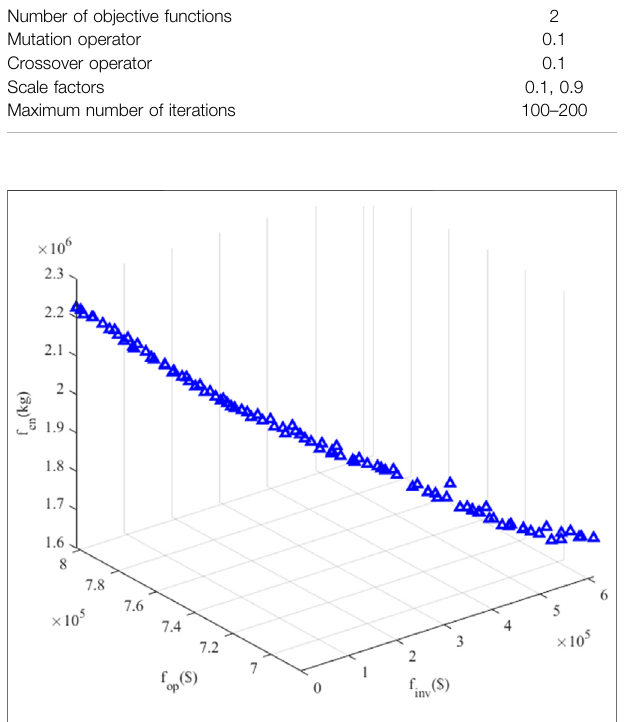
FIGURE 6 | Pareto front of the proposed optimization problem.